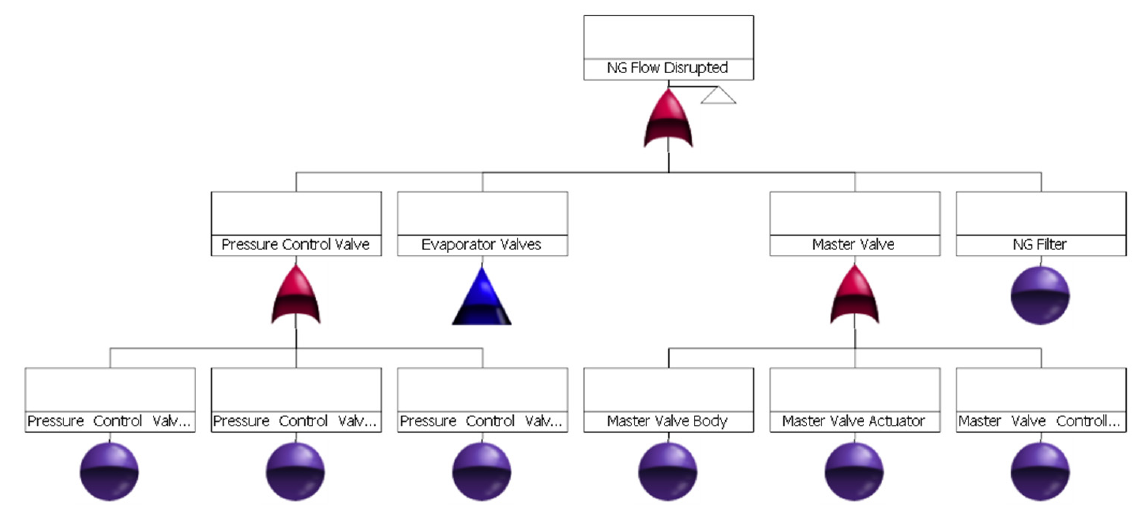
Figure A2. Fault tree for the top event of the tank pressure drop developed in PTC Windchill.